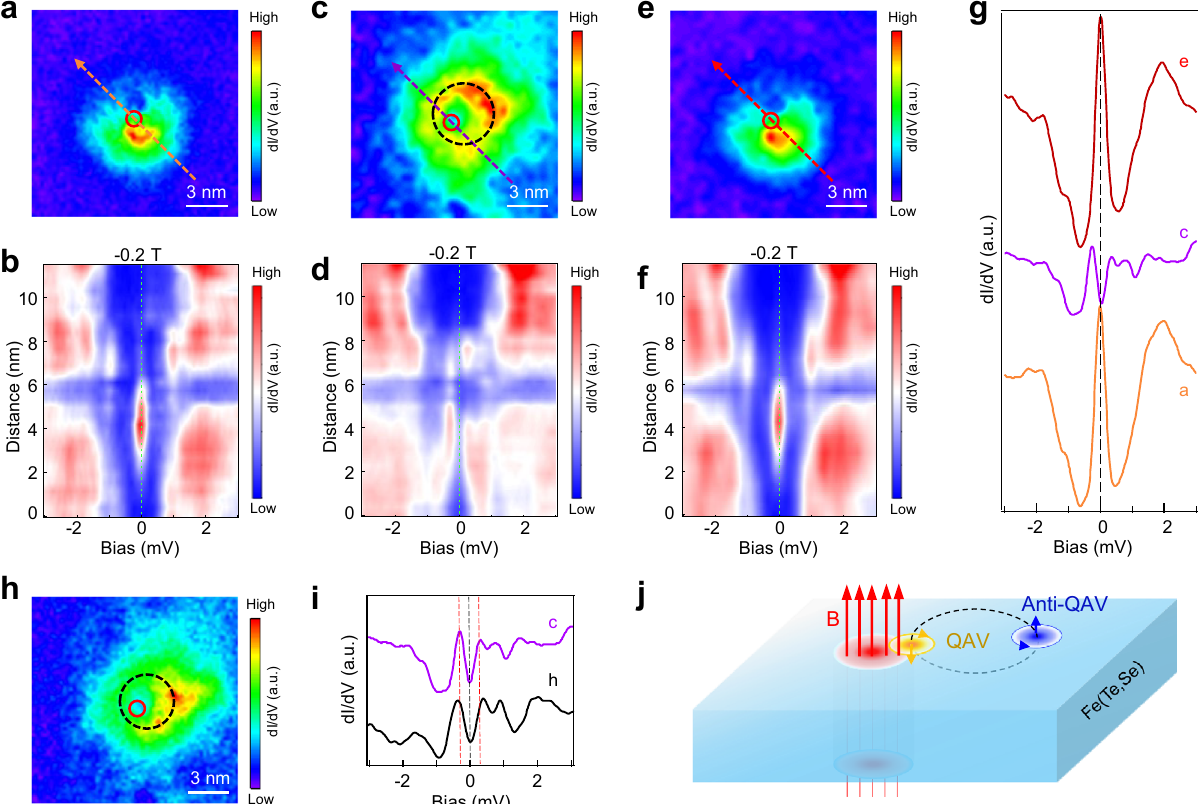
Fig. 4 Hybridization between two MZMs in the QAV and fi eld-induced vortex. a Zero-energy d I /d V map ( V s = − 10 mV, I t = 100 pA) around a type-I Fe adatom in a magnetic fi eld of − 0.2 T, showing the spatial distribution of the MZM in an isolated QAV nucleated at the adatom. b Intensity plot of d I /d V spectra ( V s = − 10 mV, I t = 200 pA) along the line-cut indicated by the arrowed red dashed line in a , showing a robust ZBP. c and d are the same as a and b , but with an additional fi eld-induced vortex pinned near the same Fe adatom visible in the zero-energy map in c . The ZBP disappears in the intensity plot of the d I /d V spectra along the same line-cut in d and two in-gap states with an energy level spacing of 0.25 meV emerge. e and f are the same as c and d , but after the fi eld-induced vortex creeps away. The MZM returns and the zero-energy d I /d V map and the intensity plot of the d I /d V spectra along the line-cut recover those in a and b . g Three d I /d V spectra obtained on the Fe adatom in a , c , and e ( V s = − 10 mV, I t = 200 pA), respectively. h Zero-energy d I /d V map around the same Fe adatom at − 3 T ( V s = − 10 mV, I t = 100 pA), showing an additional fi eld-induced vortex pinned close to the adatom. i d I /d V spectra obtained on the Fe adatom in h and c ( V s = − 10 mV, I t = 200 pA). Both spectra show disappearance of ZBP and emergence of two in-gap states separated by an energy spacing that is larger (0.35 meV) in the case of h compared to c (0.25 meV). j Schematics of the interaction between two MZMs in the QAV and the fi eld-induced